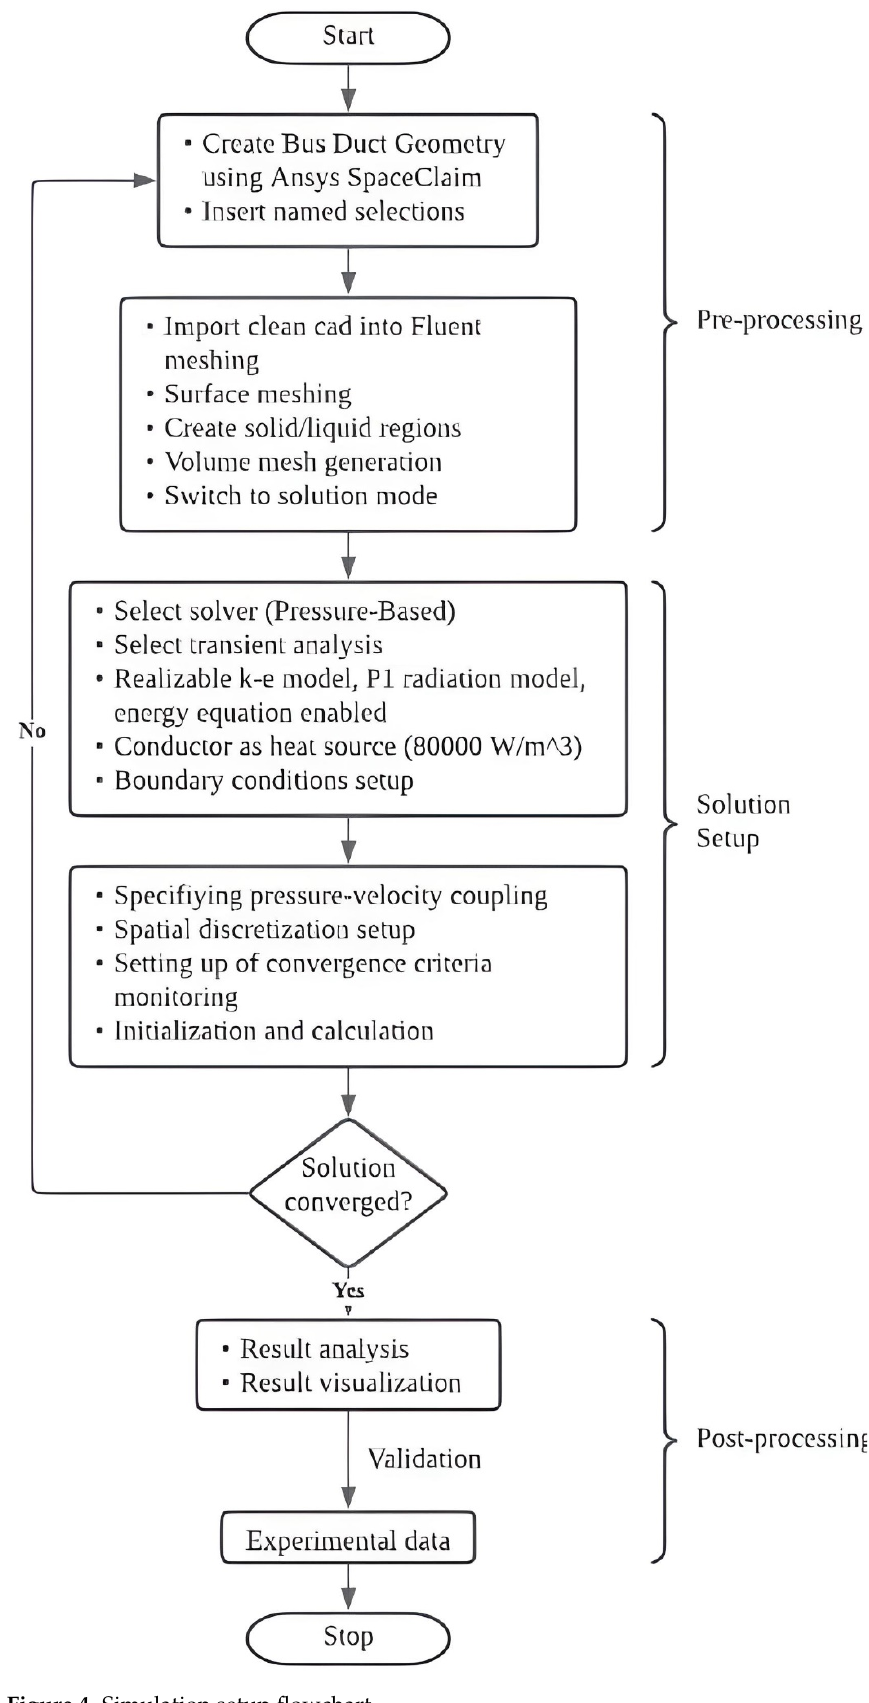
Figure 4. Simulation setup flowchart .